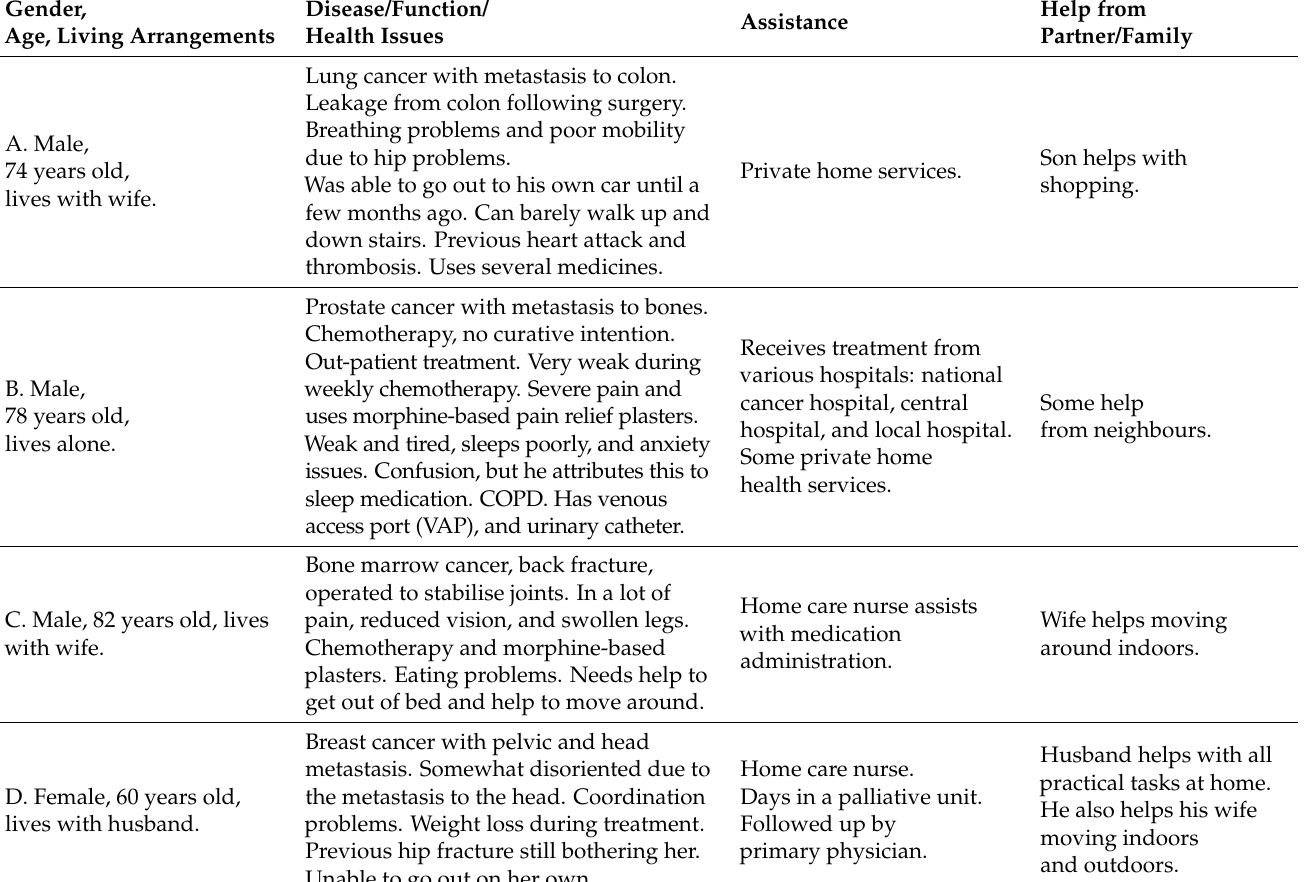
Table 1. Description of participants by gender, age, living arrangements, disease and health issues, public health services, and help from